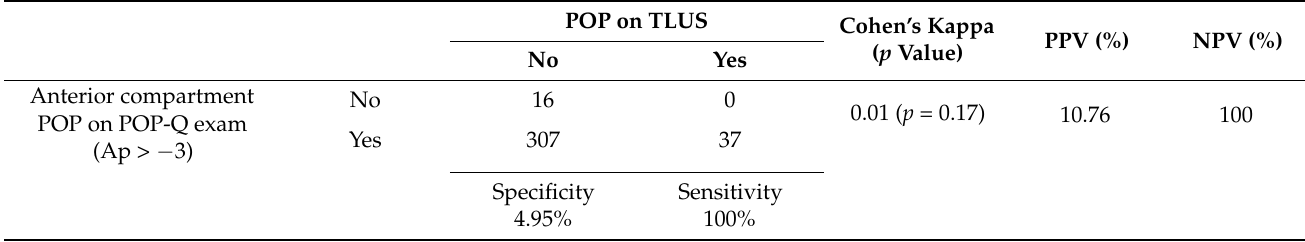
Table 4. Agreement between clinical and sonographic measurements based on the findings of pelvic organ prolapse quantification (POP-Q) and translabial ultrasound (TLUS) in 360